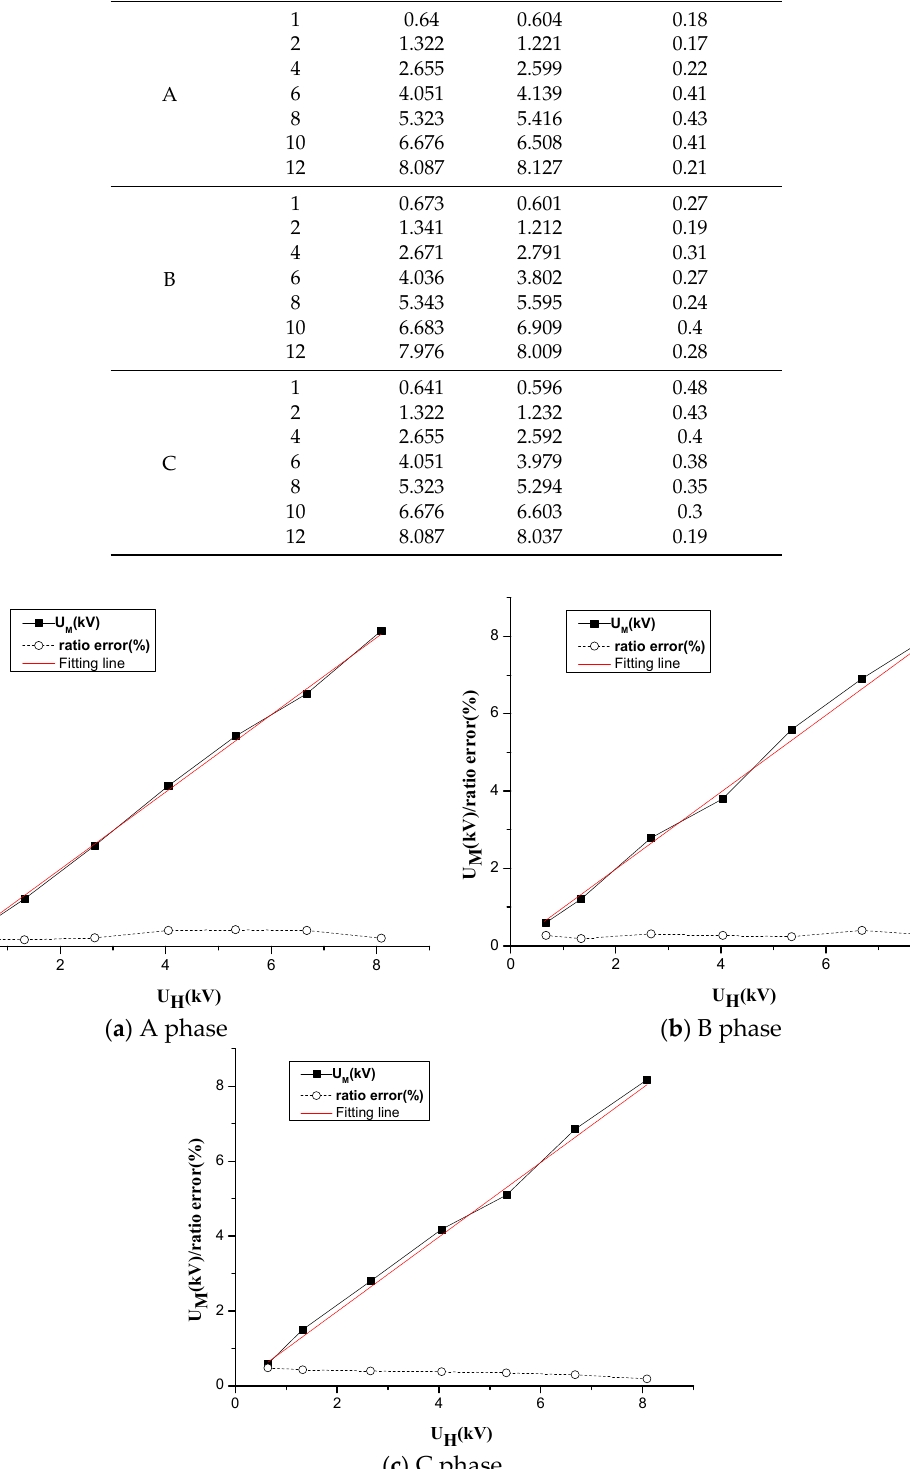
Figure 9. Calibration and ratio curve of the sensor and the HV-probe.